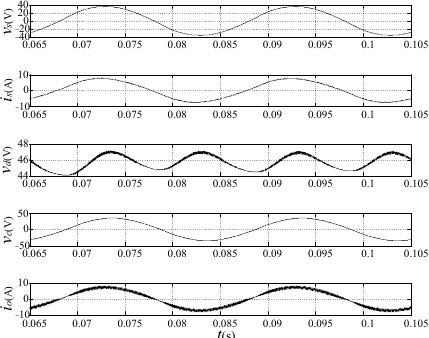
Figure 7. Waveforms under traditional modulation strategy.